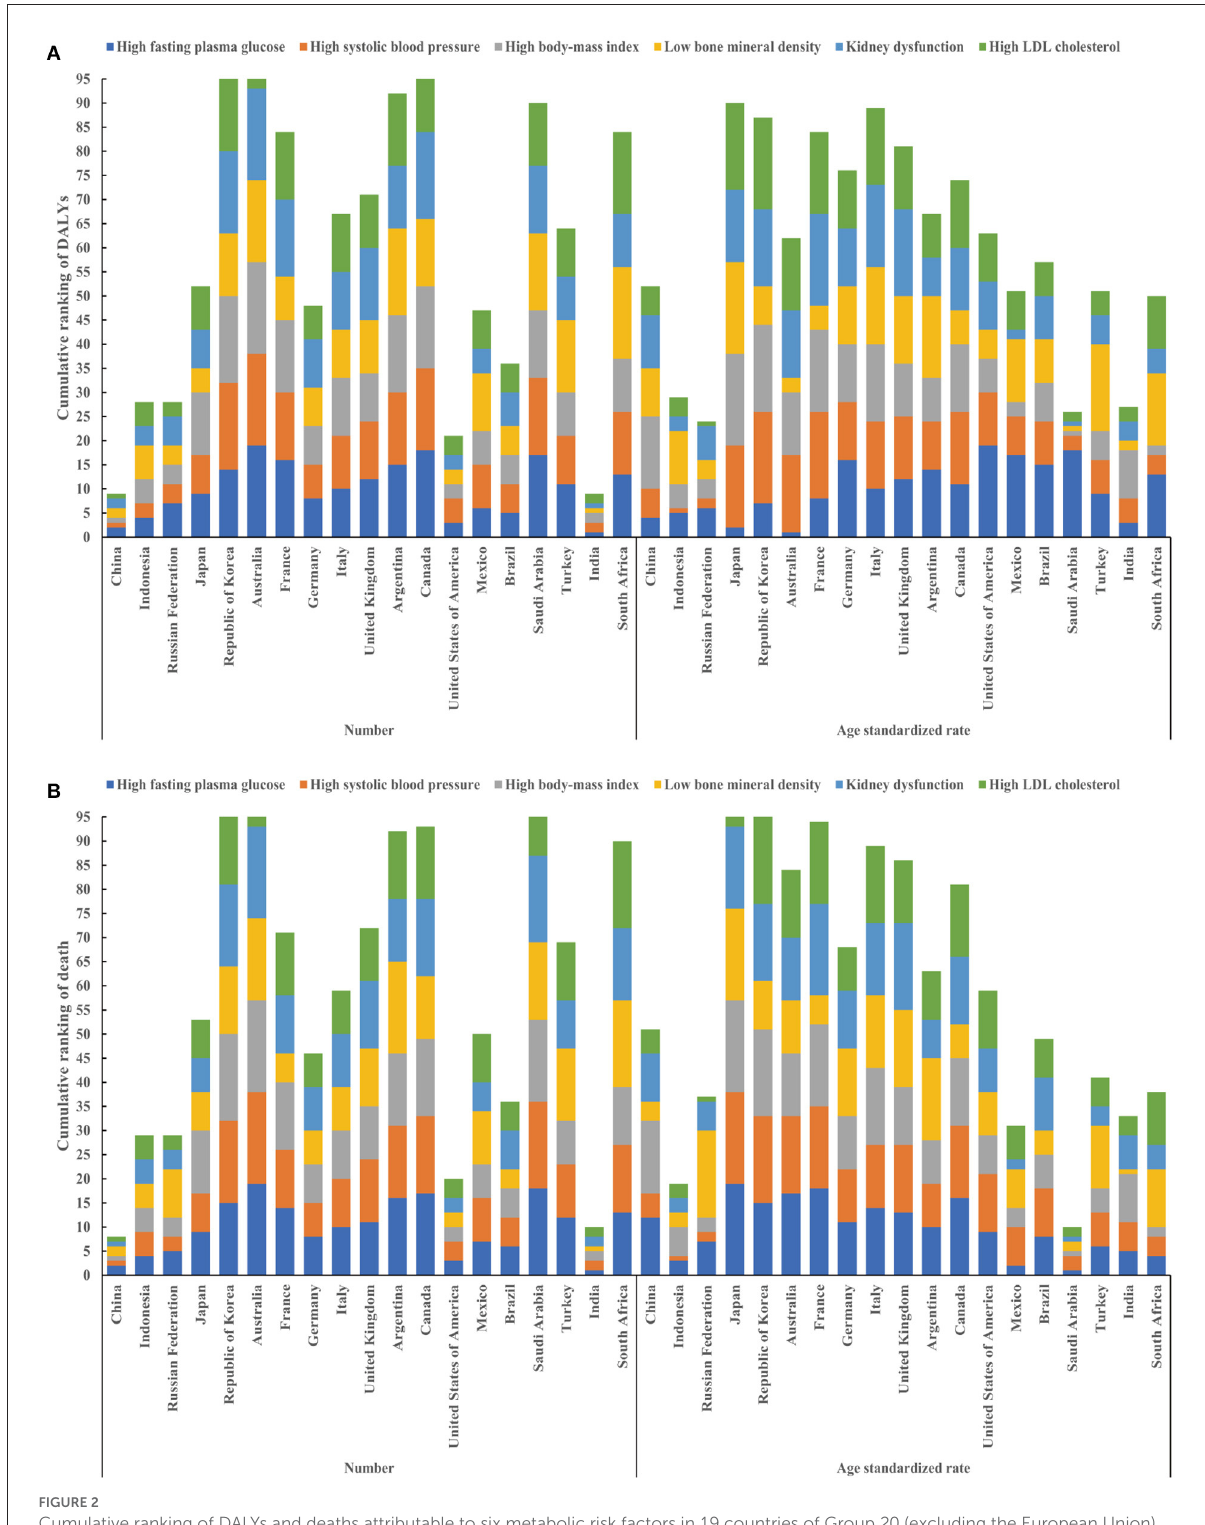
FIGURE2 Cumulative ranking of DALYs and deaths attributable to six metabolic risk factors in 19 countries of Group 20 (excluding the European Union). Cumulative ranking of number (left) and age standardized rate (right) of DALYs attributable to six metabolic risk factors in 19 countries of Group 20 (A) ; Cumulative ranking of number (left) and age standardized rate (right) of deaths attributable to six metabolic risk factors in 19 countries of Group 20 (B) . DALYs, disability-adjusted life